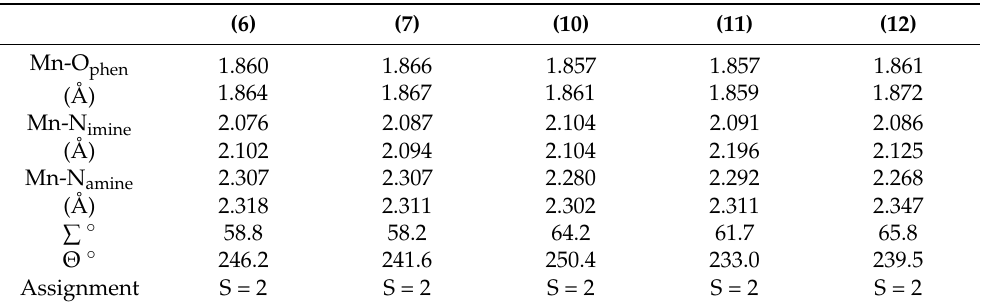
Table 4. Metal-Ligand bond lengths and distortion angle parameters, ∑ (angular deviation at the origin) and Θ (trigonal torsion angle) for complexes 6 , 7 , and 10 – 12 at 100